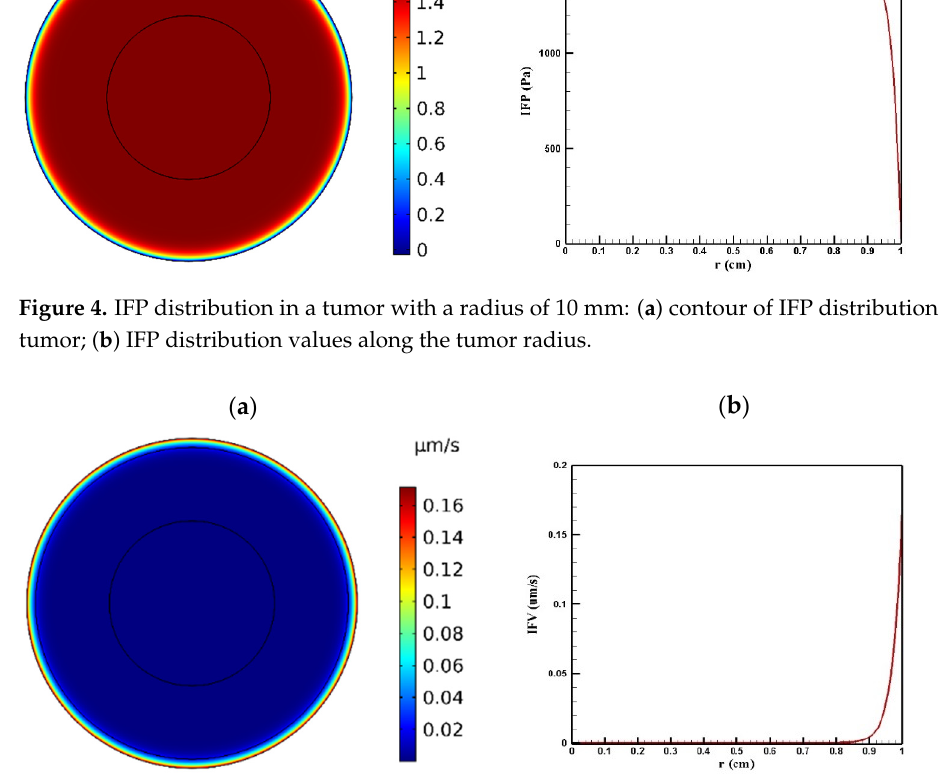
Figure 5. IFV distribution in a tumor with a radius of 10 mm: ( a ) contour of IFV distribution in the tumor; ( b ) IFV distribution values along the tumor radius.